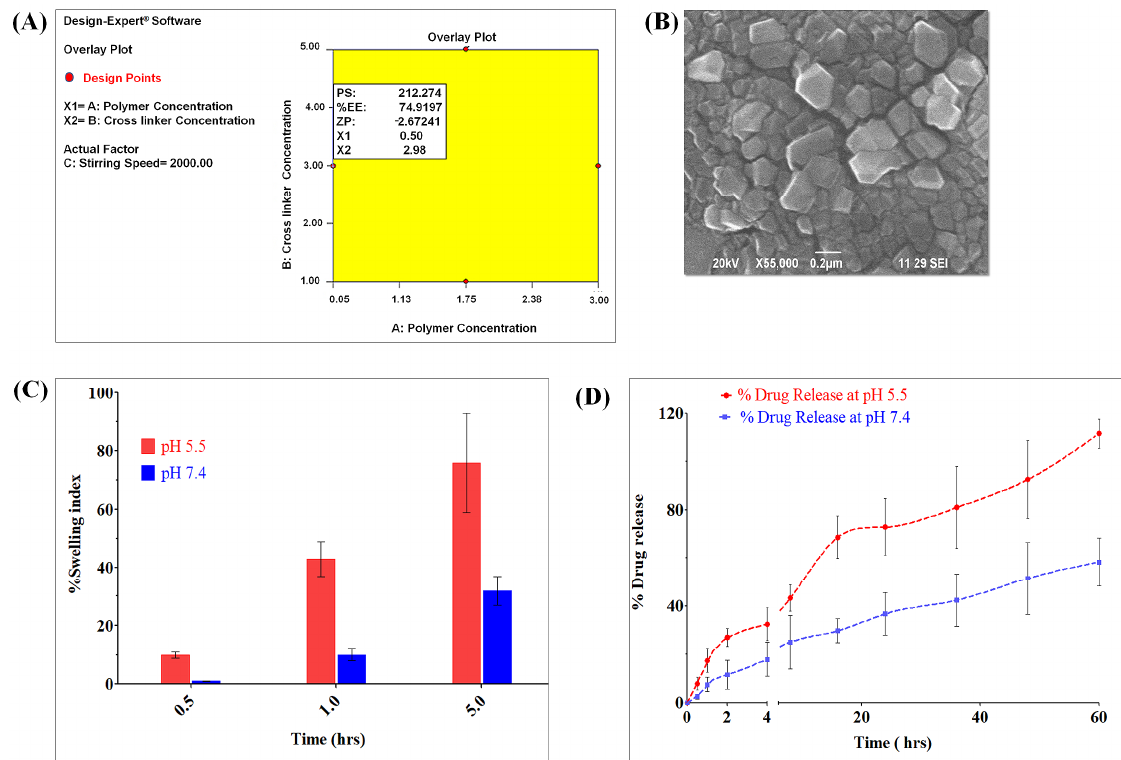
Figure 2. ( A ) Overlay plot obtained for the OCMC-MET polymeric nano-formulation optimized by the DoE approach. ( B ) SEM morphological study of OCMC-MET at 0.2 µm scale showed that due to high charges the aggregated spherical of OCMC-MET Nps. ( C ) Swelling index of the polymeric Nps in different pH after 0.5 h, 1 h, and 5 h. ( D ) In vitro MET release from OCMC polymeric Nps in two different pH conditions ( n = 3).